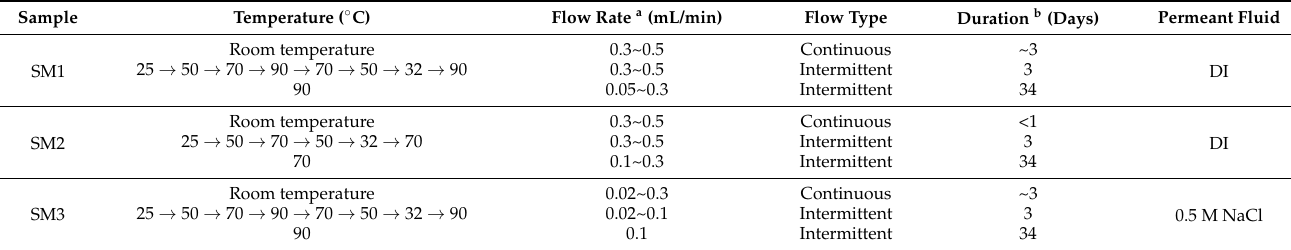
Table 2. Experimental